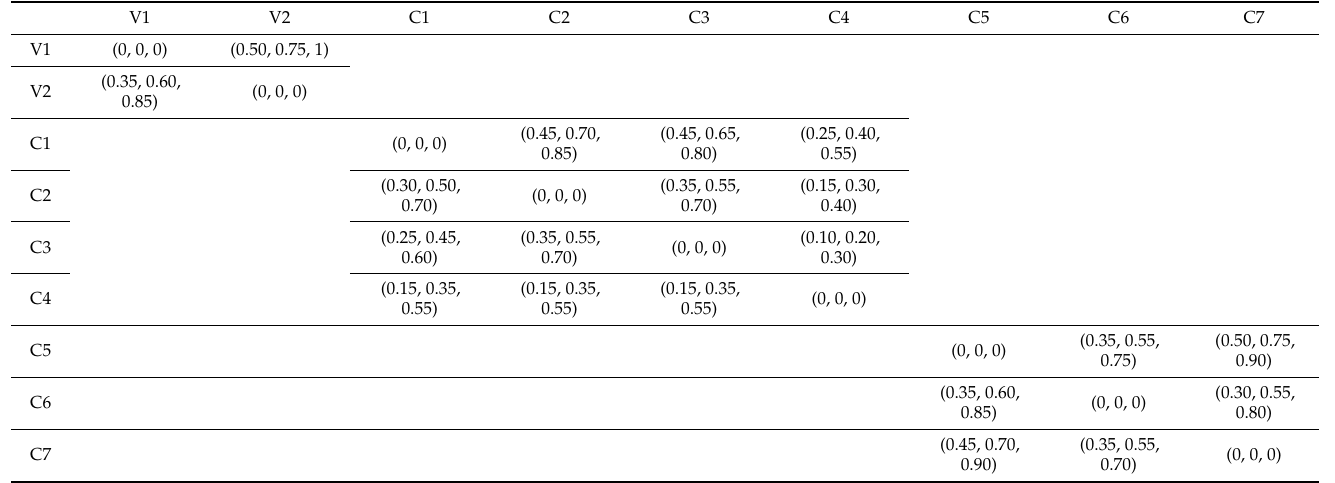
Table 2. Direct relation